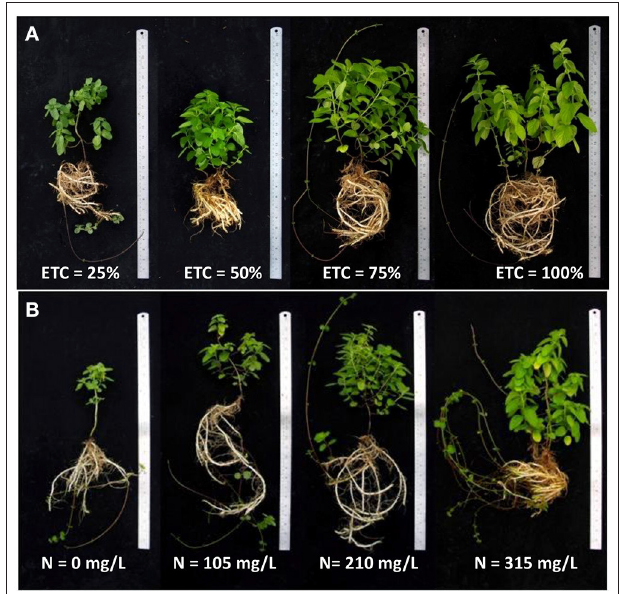
FIGURE 1 | The morphology of potted Mentha arvensis grown in the evaporative greenhouse system with different water regimes (A) and different levels of nitrogen fertigation (B)